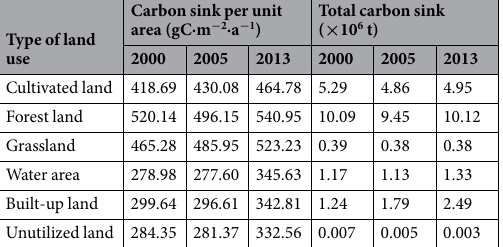
Table 1. Carbon values of different land use types in the Pearl River Delta area.